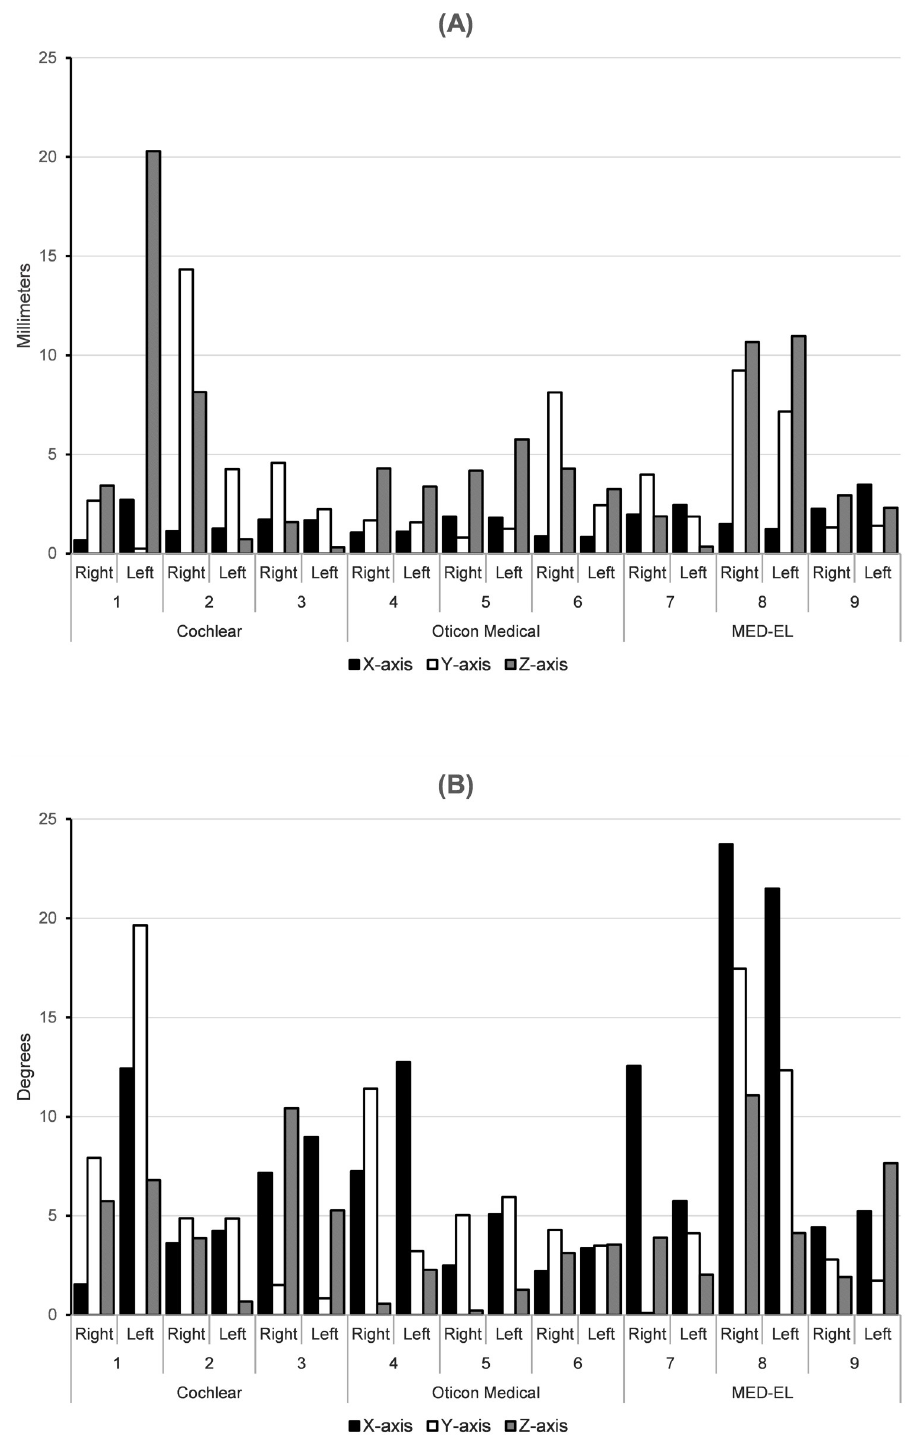
Fig 3. Translational and rotational deviations (absolute values) per case between the planned CI and implanted CI, expressed in millimeters and degrees. (a)Translational deviations (absolute values) in millimeters per axis, per case; (b)Rotational deviations (absolute values) in degrees per axis, per case; Horizontal numbers represent the specimens.